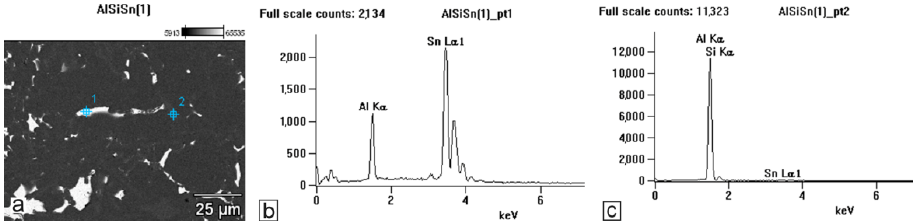
Figure 12. SEM-EDS analysis of microstructure and chemical composition of Si10Sn1.7 alloy: ( a ) image of microstructure with analysis points; ( b ) plot of spectra in Area 1; ( c ) plot of spectra in Area 2.